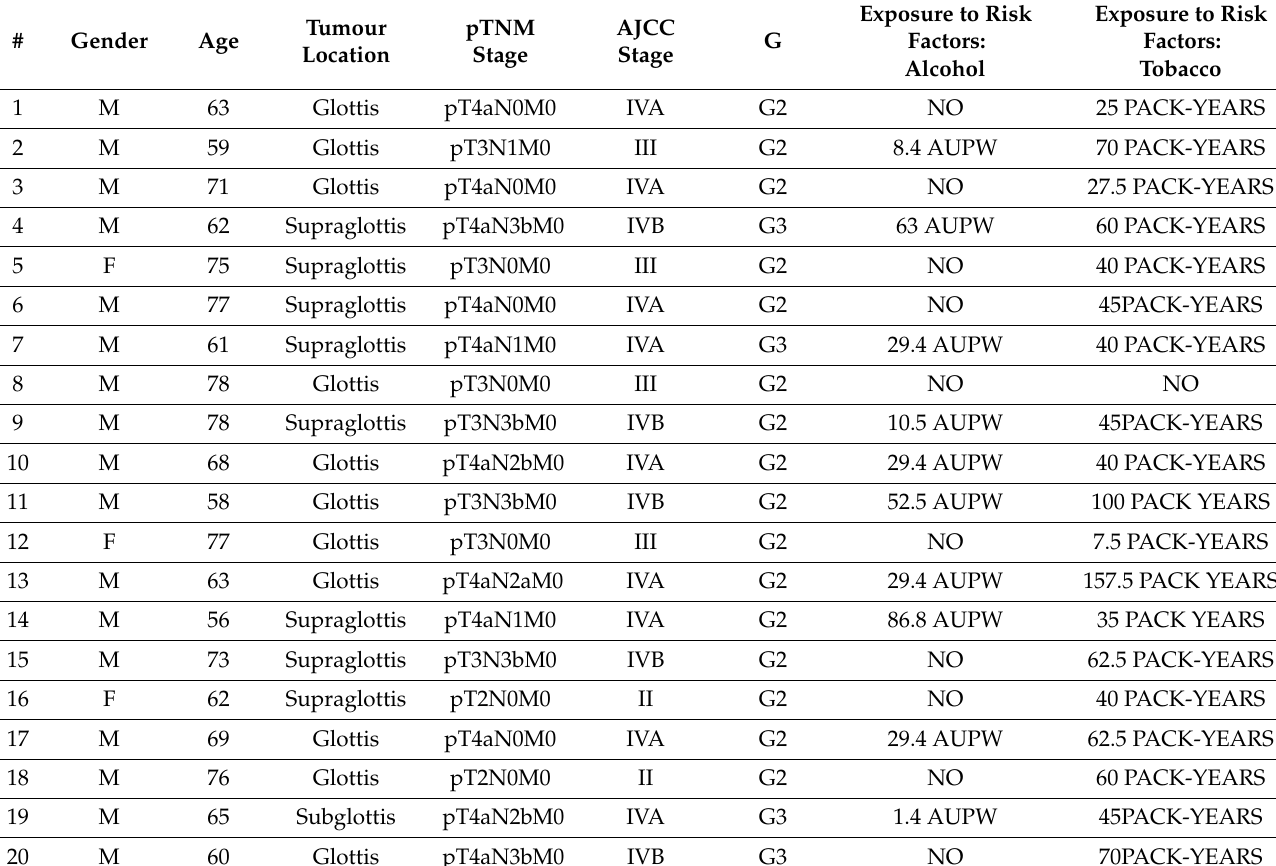
Table 1. Clinical synopsis of the patients with LSCC included in this study. TNM, stage, and grade were based on AJCC [32]. A pack-year (PY) is used to define how many cigarettes you have smoked in your lifetime, with a pack equal to 20 cigarettes. Currently, having 20 pack-years or more is one of the criteria that needs to be met to be recommended for screening. Alcohol units per week (AUPW) define the quantity of pure alcohol in a drink. One unit equals 10 mL or 8 g of pure alcohol, which is around the amount of alcohol the average adult can process in an